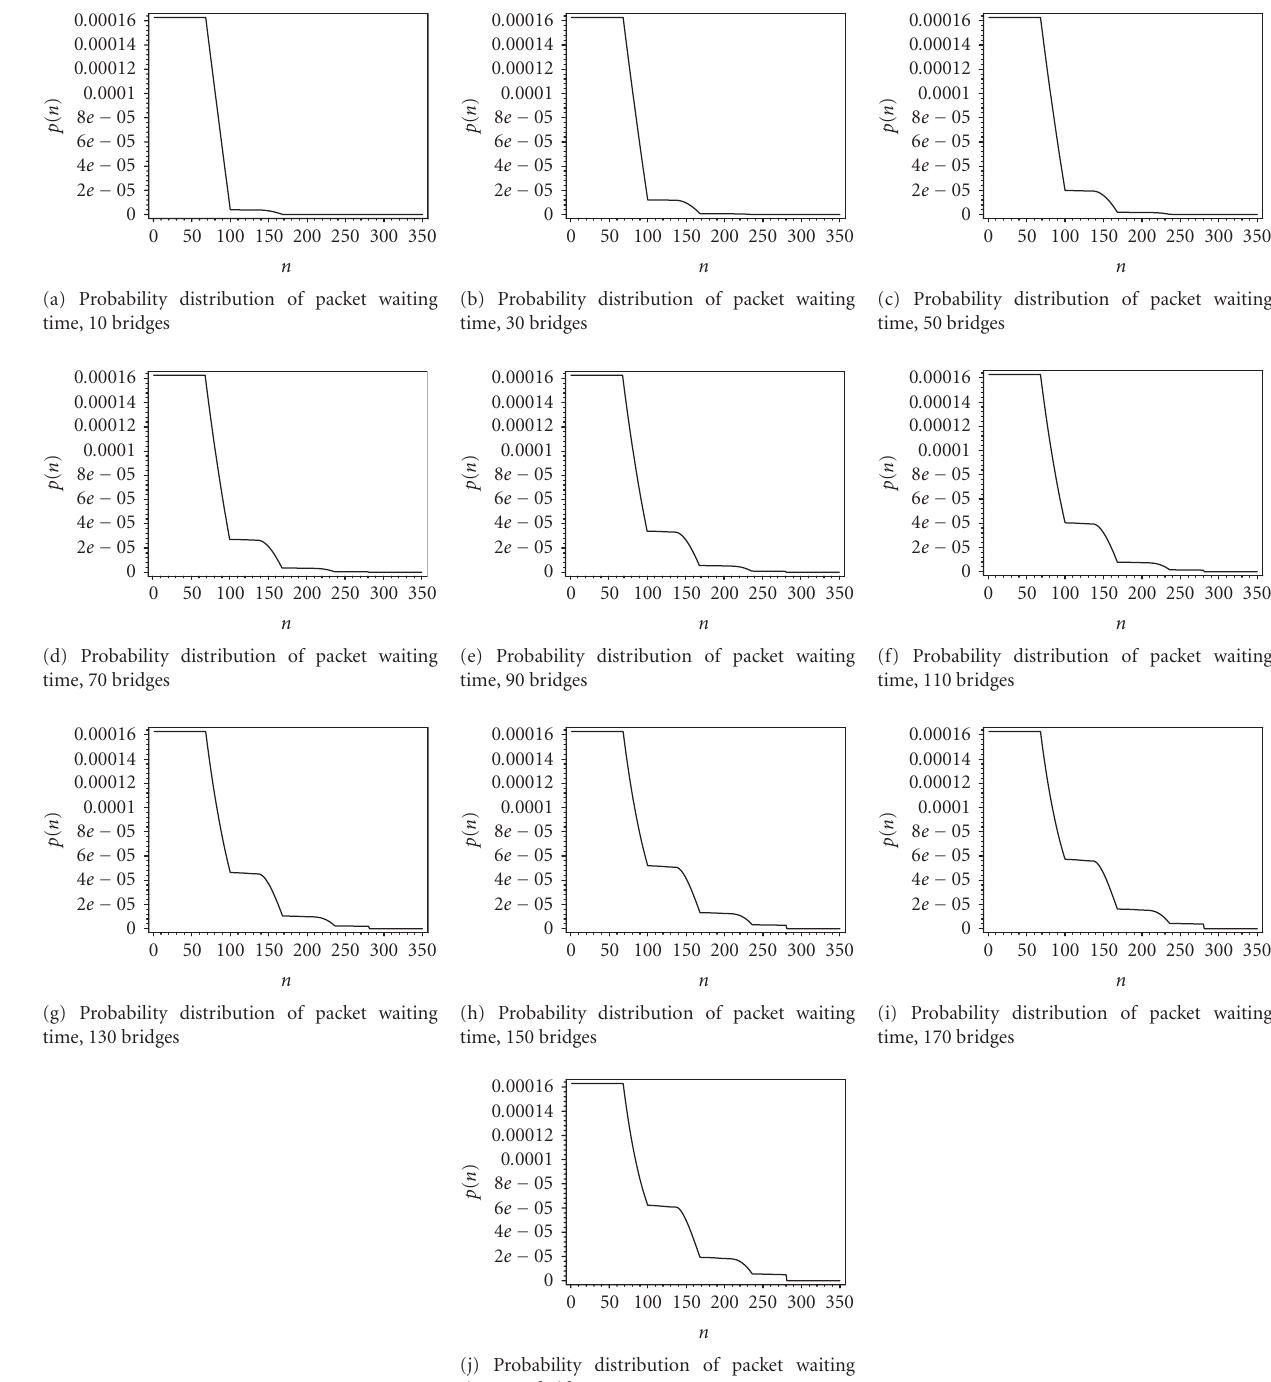
Figure 10: Probability distribution of packet waiting time in bridges’ bu ff er.